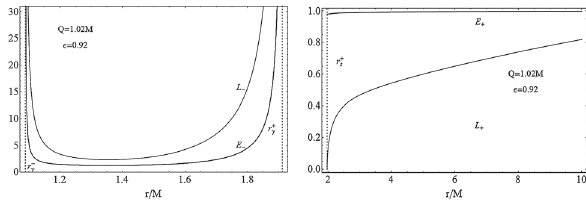
√ Fig. 11 Class : M < Q ≤ 5 /( 2 6 ) M and (cid:9)(cid:9) (cid:2) + ≤ (cid:2) < M / Q . Param- eter choice is as follows: Q = 1 . 02 M and (cid:2) = 0 . 92. Then (cid:9)(cid:9) (cid:2) + = 0 . 914942, M / Q = 0 . 980392 , r + s = 1 . 96981 M , r − γ = 1 . 08866 M , and r + γ = 1 . 91134 M .Circularorbitsexistwithangularmomentum L = L + ( gray curves ) and energy E = E + ( black curves ) in r − γ < r < r + γ ( left plot ) and L = L − in r > r + s ( right plot )